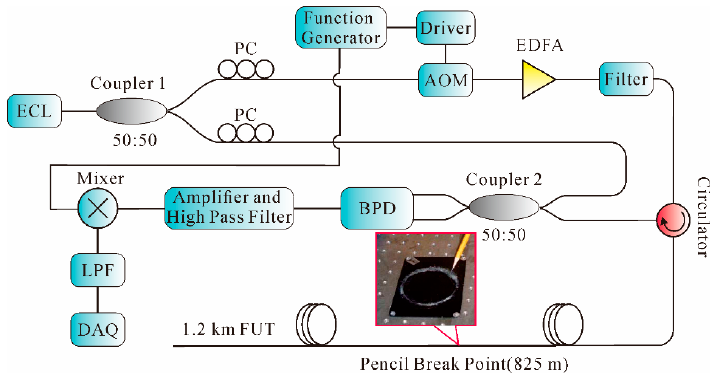
Figure 10. Experimental setup for coherent Φ -OTDR, adapted from Bao et al. [90].